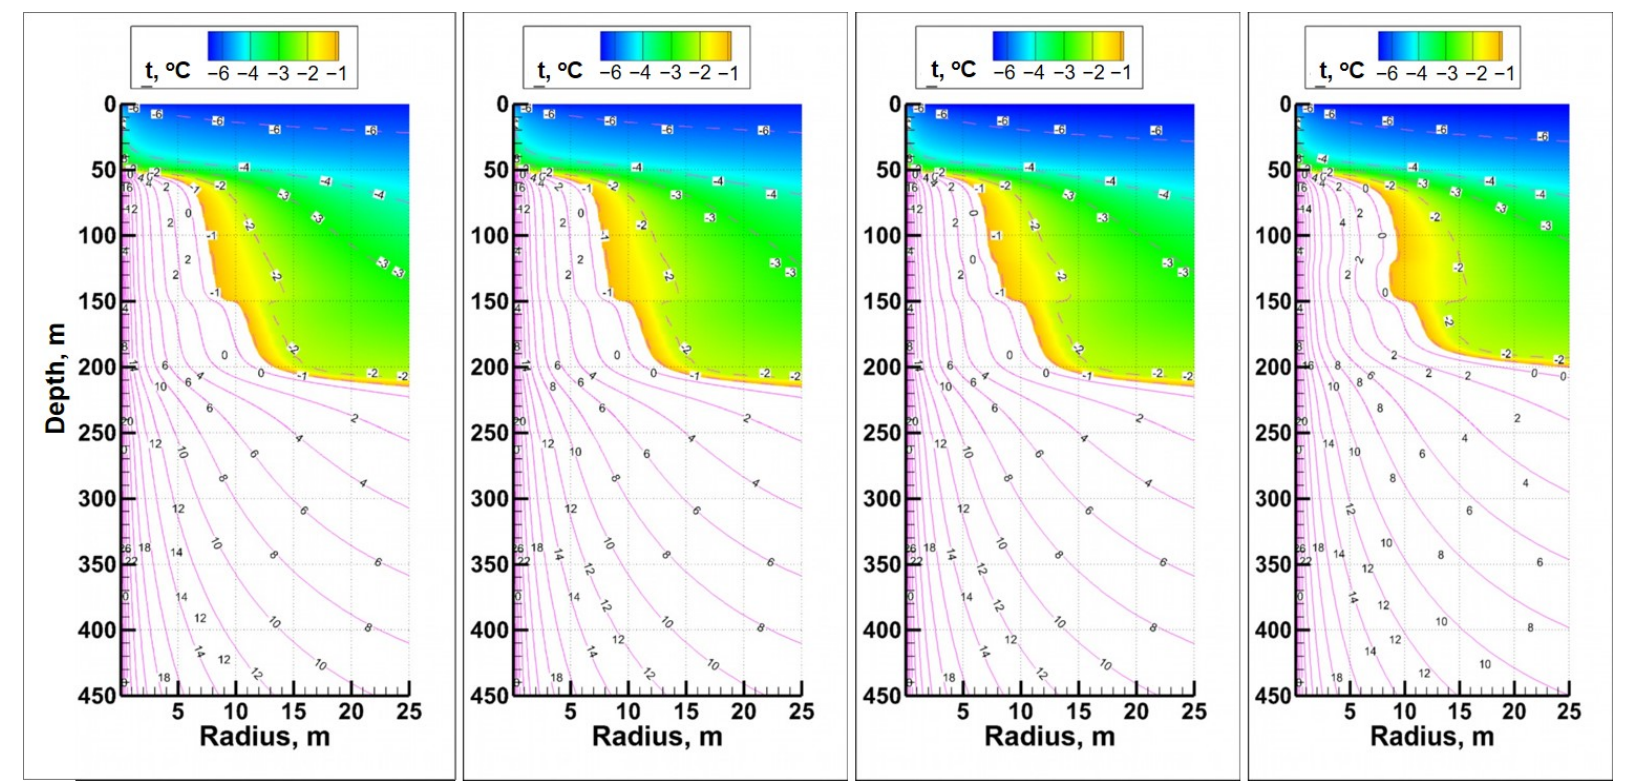
Figure 8. Permafrost temperature variations around a producing gas well (along the radius off the well center) after 30 years with different hydrate saturations of 0%, 20%, and 40% ( S h + S i = 100%), and incomplete pore filling with hydrate S h = 20%; ice S i = 50% (left to right) in depth interval of 60–120